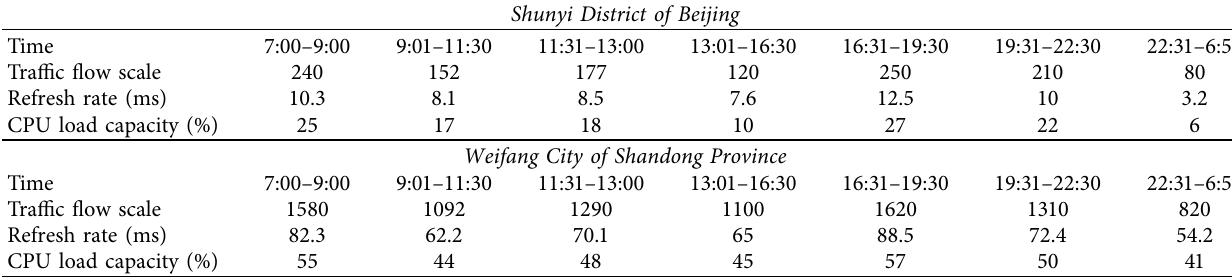
Table 3: Simulation platform performance test